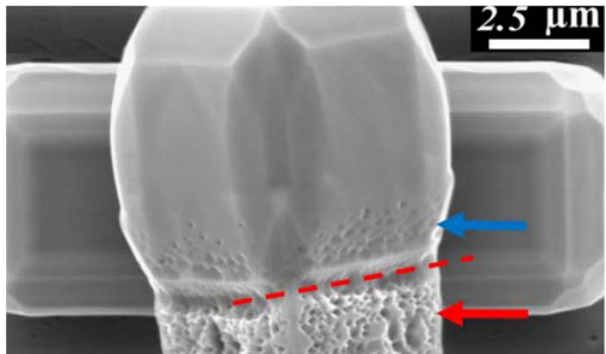
Figure 3. Lateral expulsion of dislocations. SEM image showing confinement of etch-pits in the bottom pillar region for a Ge 0.2 Si 0.8 /Si(001) crystal. Reproduced with permission from [20]. American Institute of Physics.